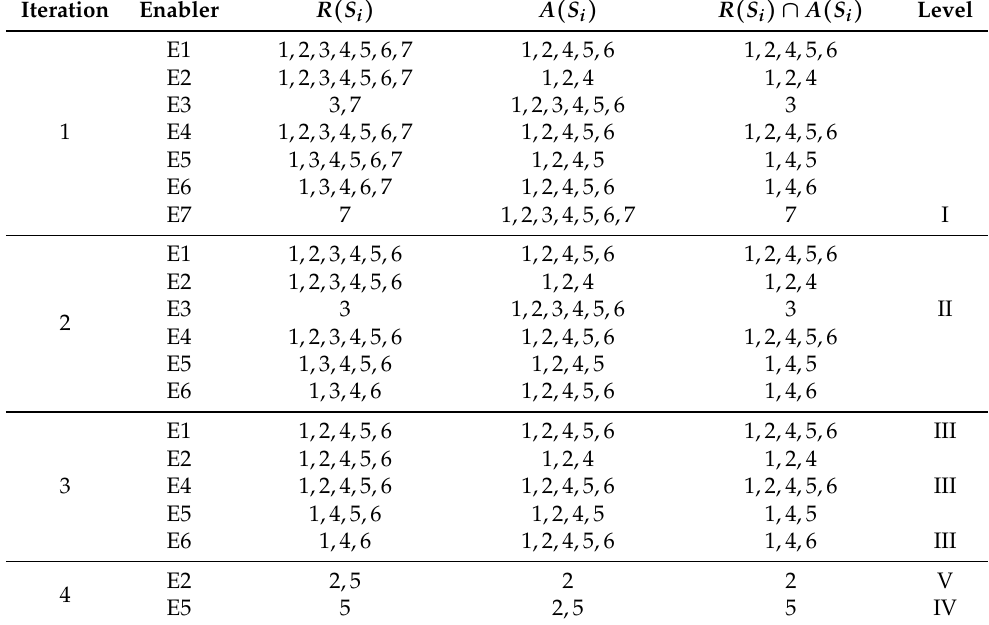
Table 7. Level identification.